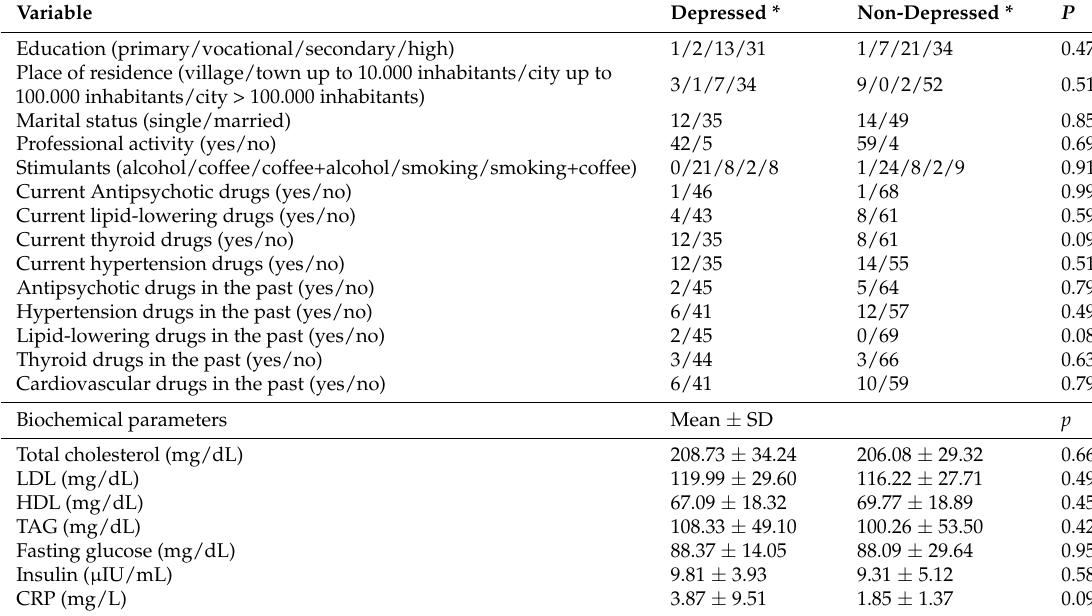
Table 1. Sociodemographic and health-related characteristics of study